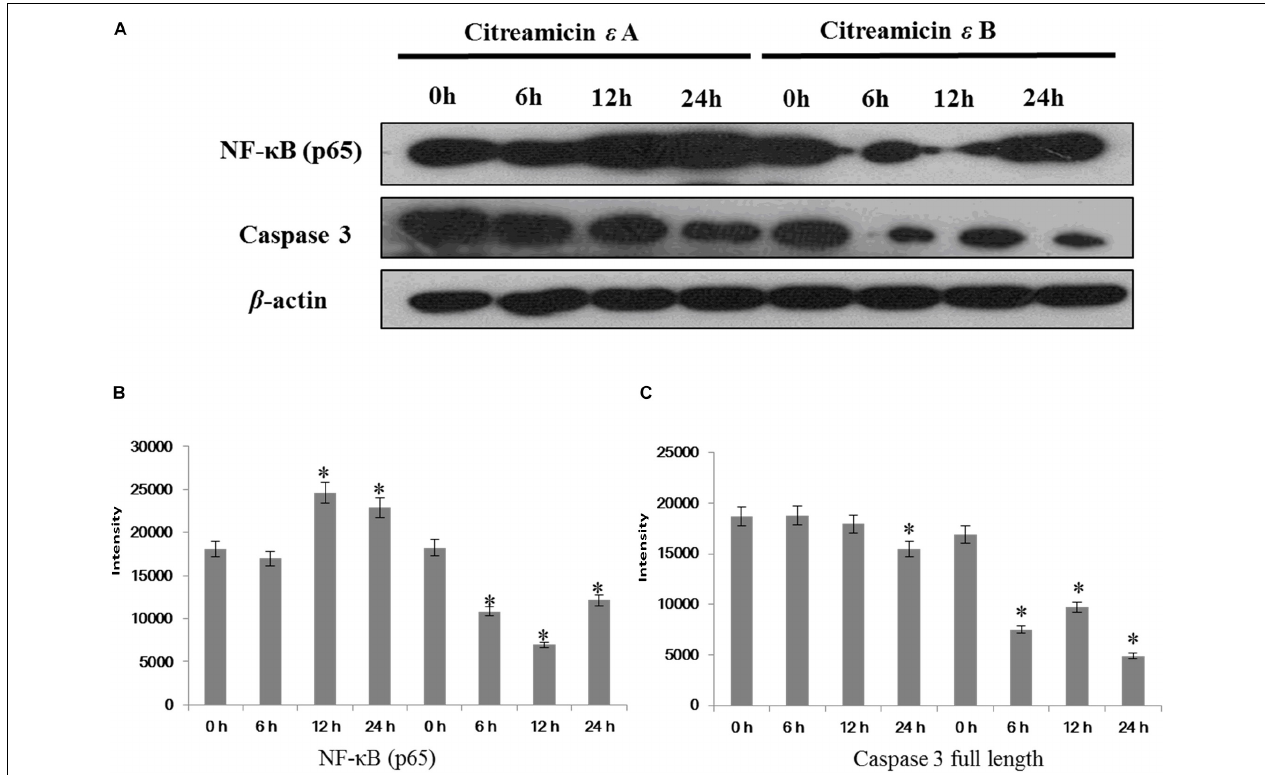
FIGURE 6 | Nuclear transcription factor κ B (NF- κ B)/p65 activation through citreamicin ε A and B treatment in PtK2 cells. Western blot analysis of NF- κ B/p65 and caspase-3 (full length) in PtK2 cells treated with 0.1 µ M citreamicin ε A and B for 6, 12, and 24 h. (A) The quantitative of the expression of NF- κ B (B) , and the quantitative of the expression of caspase 3 full length (C)